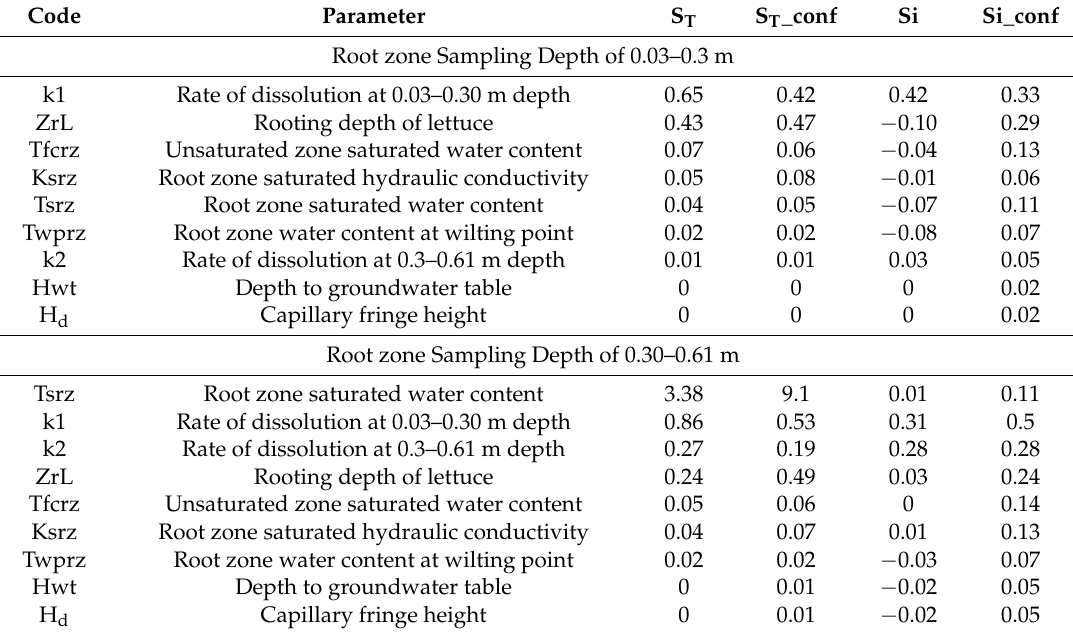
Figure 6. Morris method µ * (the absolute of the mean elementary effect) vs. σ (the standard deviation of the elementary effect) for the different soil depths. Table 6. Sobol’s sensitivity